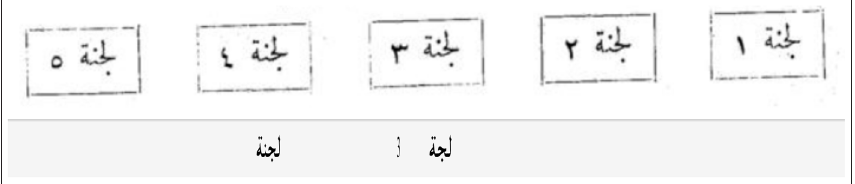
Figure 23: Example of particularly poor transcription on an atypical (table) presentation format.